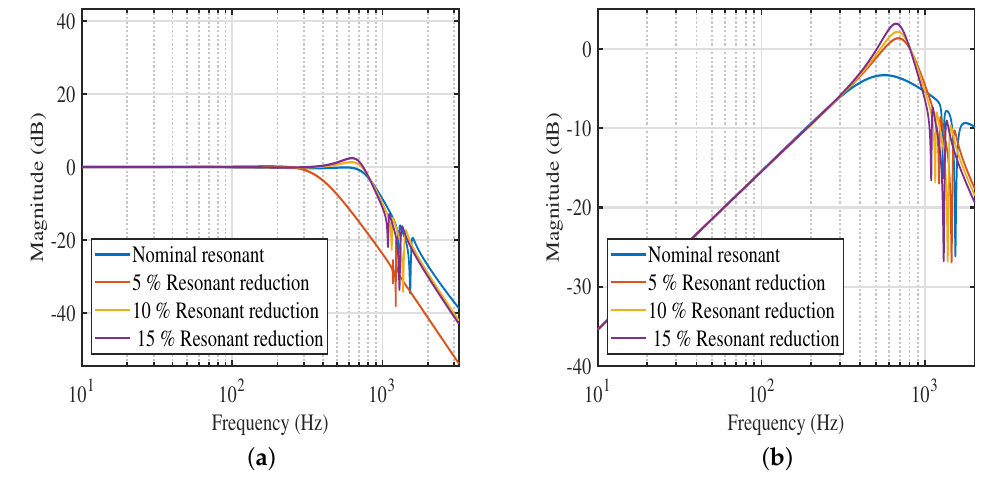
Figure 3. ( a ) Closed-loop magnitude response under resonant frequency changes for PAVPF scheme; ( b ) Disturbance rejection profile for various resonant frequency changes for PAVPF scheme.